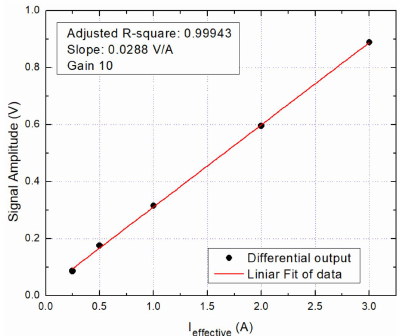
Figure 19. 8 Oe biased sensors: AC calibration curve within the 0–3 A